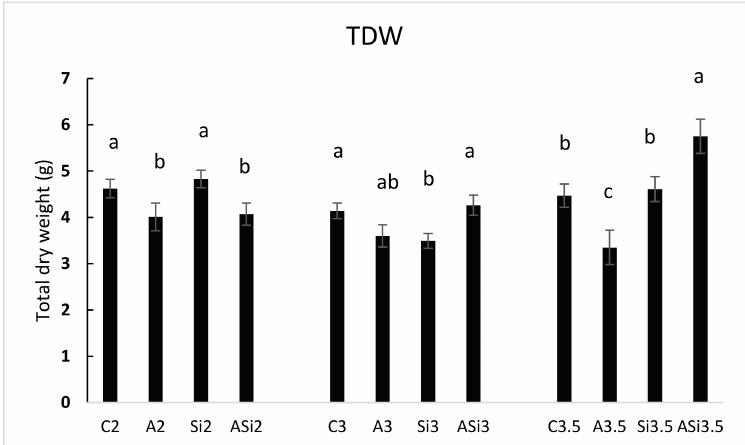
Figure 7. TDW (g) at the end of the trial for the C2 (foliar application with water and fertigation EC 2.0 dS m − 1 ), A2 (foliar application with Arthrospira platensis and fertigation EC 2.0 dS m − 1 ), Si2 (foliar application with Si and fertigation EC 2.0 dS m − 1 ), ASi2 (foliar application with Arthrospira platensis and Si, and fertigation EC 2.0 dS m − 1 ), C3.0 (foliar application with water and fertigation EC 3.0 dS m − 1 ), A3.0 (foliar application with Arthrospira platensis and fertigation EC 3.0 dS m − 1 ), Si3 (foliar application with Si and fertigation EC 3.0 dS m − 1 ), ASi3 (foliar application with Si and Arthrospira platensis , and fertigation EC 3.0 dS m − 1 ) treatments; C3.5 (foliar application with water and fertigation EC 3.5 dS m − 1 ), A3.5 (foliar application with Arthrospira platensis and fertigation EC 3.5 dS m − 1 ), Si3.5 (foliar application with Si and fertigation EC 3.5 dS m − 1 ), and ASi3.5 (foliar application with Si and Arthrospira platensis, and fertigation EC 3.5 dS m − 1 ) treatments. Di ff erent letters indicate significant di ff erences between treatments at the p < 0.05 level using the LSD test. Values are the means of 12 plants. Error bars show standard